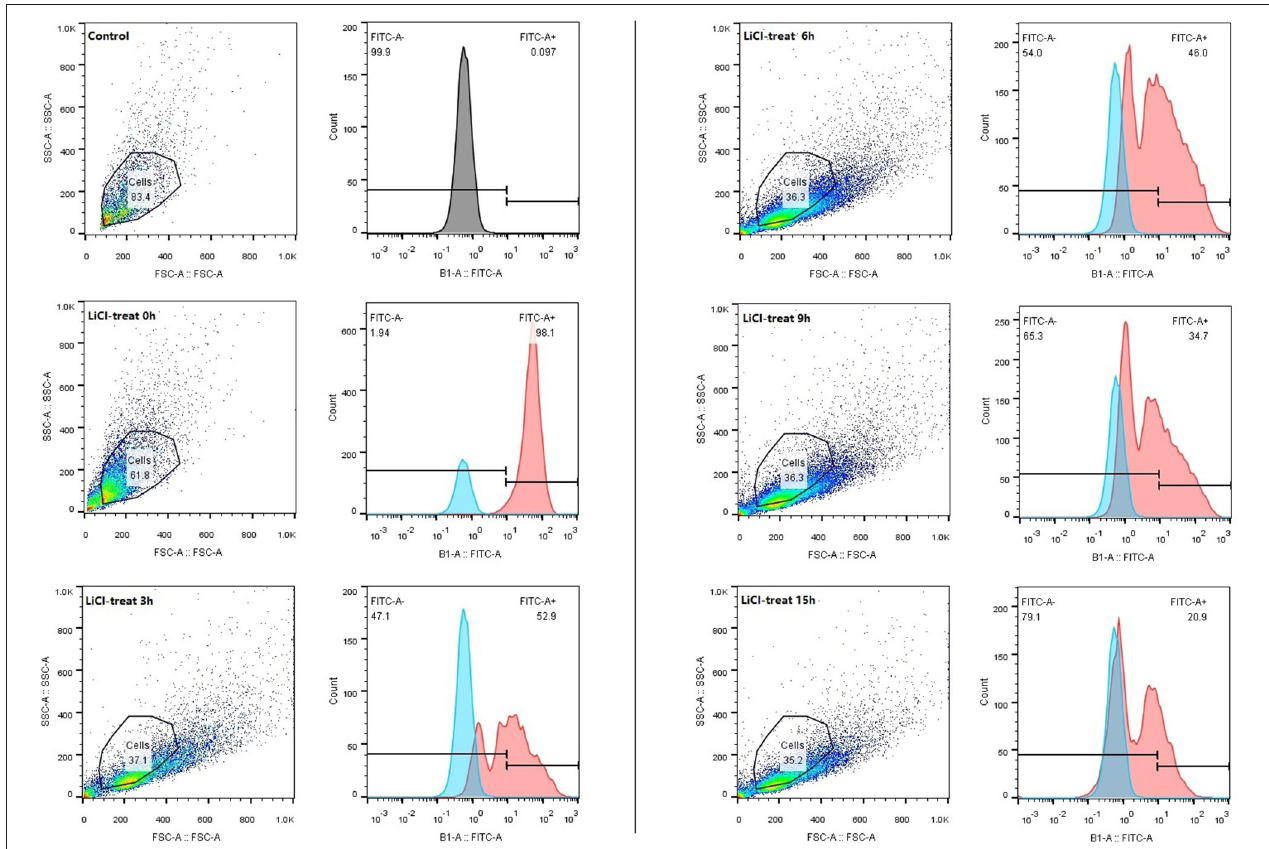
FIGURE 4 | The adhesion rate of the L. plantarum HC-2 to the HCT116 cells was analyzed by flow cytometry. After being labeled with FITC, the bacteria were washed with sterile PBS 5 times, the concentration of the bacteria was adjusted to 10 8 CFU/mL and added into the cell culture well. Incubation was terminated after 2h. The bacteria were washed with sterile PBS 3 times, and 250 µ L 0.25% of trypsin-EDTA was added into each well and incubated for 10min. About 250 µ L serum was added to stop digestion. Cell suspensions were collected and examined by flow cytometry.